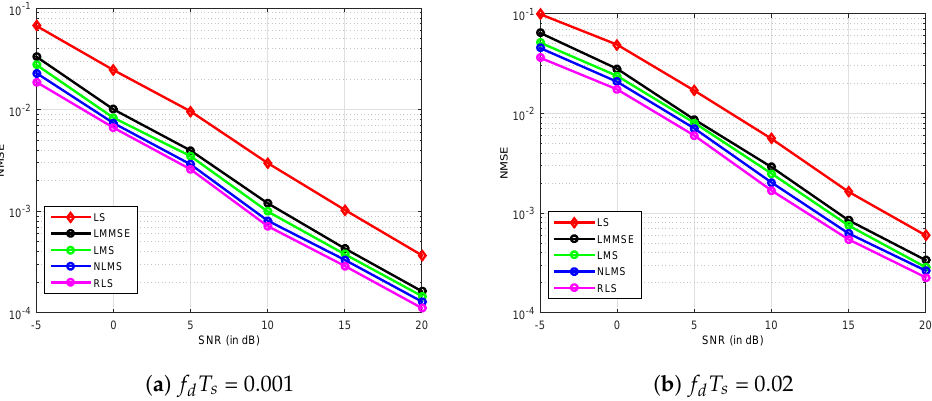
Figure 25. Estimators performance comparison in terms of NMSE versus SNR: Non-PR filter